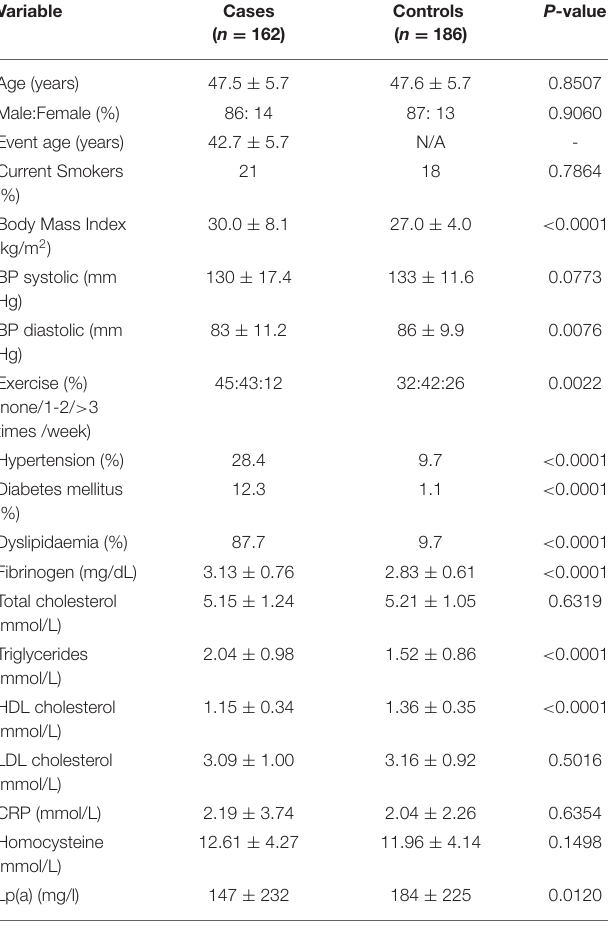
TABLE 1 | Demographic variables in the PRAMIS cases and